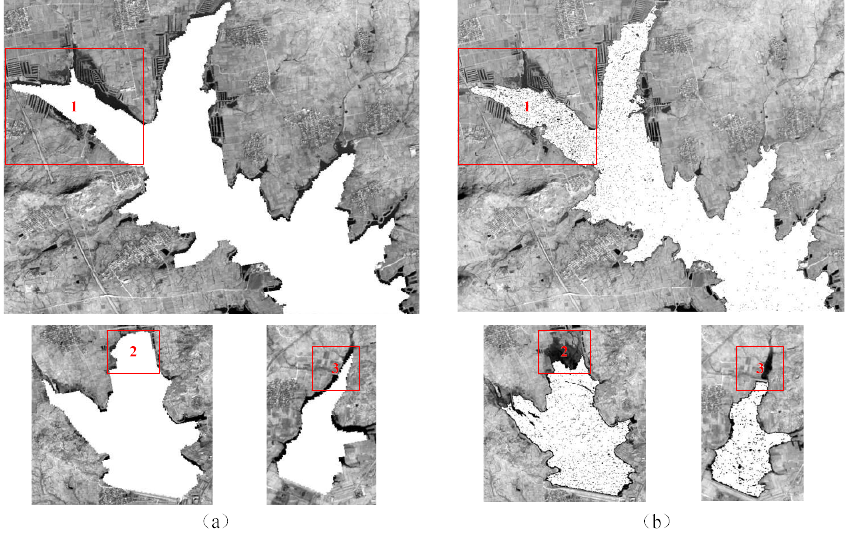
Figure 9. The comparison of the water masks and the ROIs for image pair block 2. ( a ) FROM-GLC10 water masks. ( b ) ROIs.